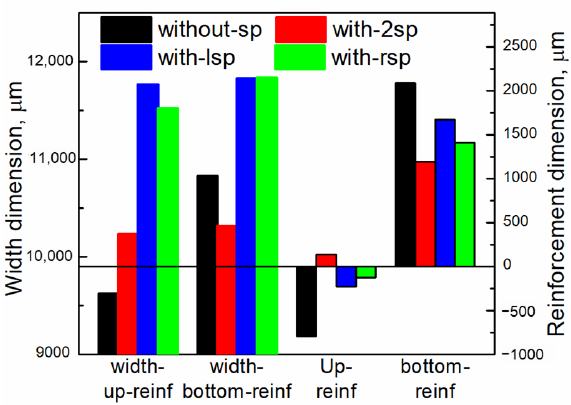
Figure 14. Comparison of cross-section dimension for different supporting cases.